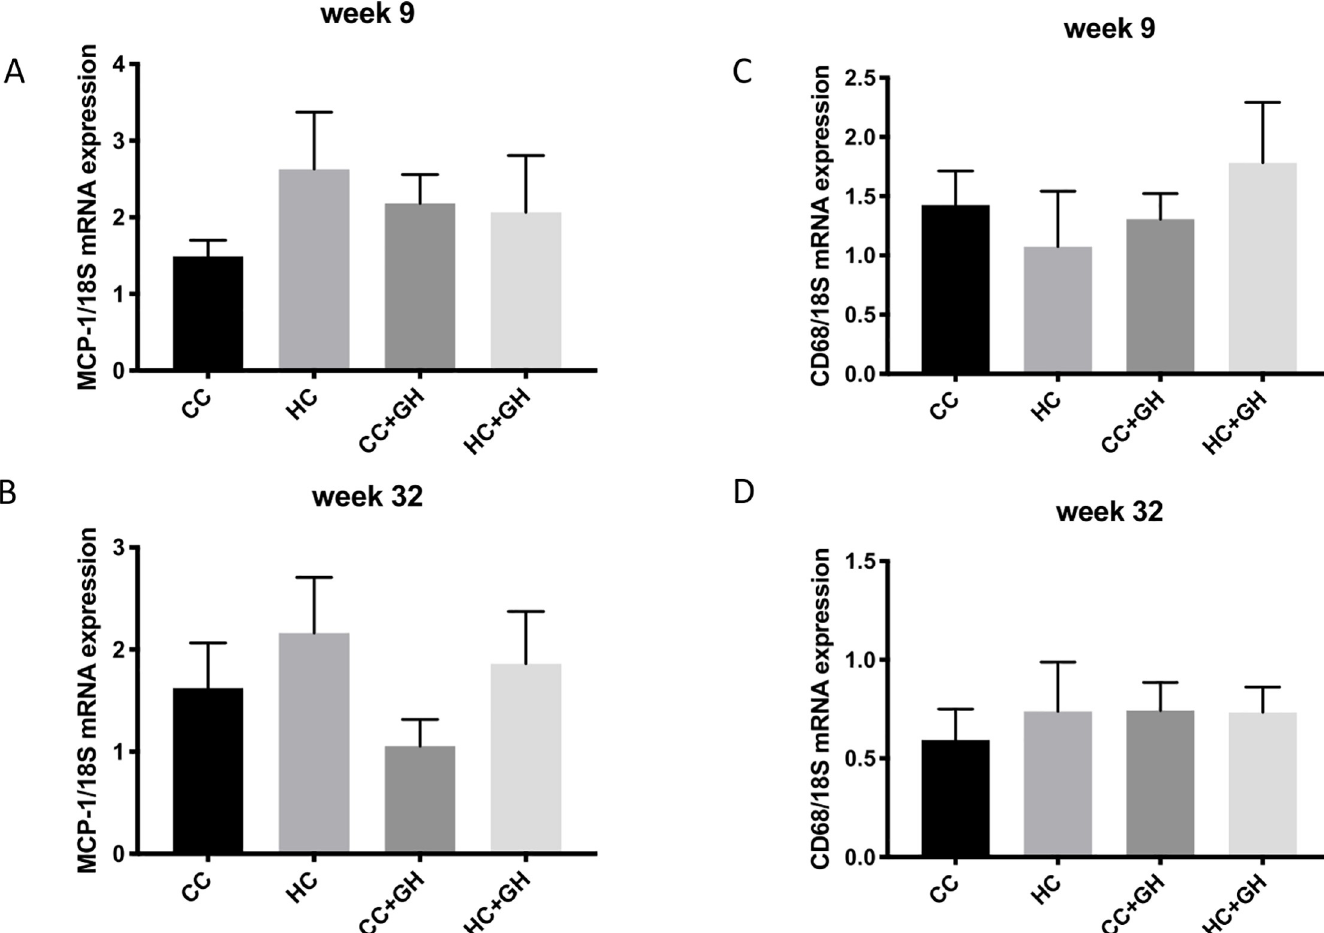
Fig 13. Kidney inflammation. (A, B) Renal MCP-1 mRNA expression in offspring at week 9 and week 32, (C, D) Renal CD68 mRNA expression in offspring at week 9 and week 32. Results expressed as mean ± SEM, n = 6.